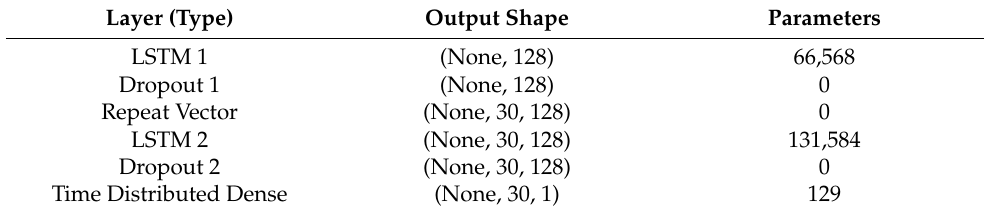
Table 2. The LSTM auto-encoder model summary.